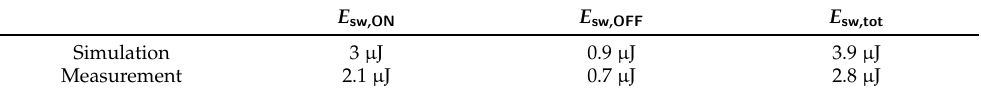
Figure 6. Comparison between simulation and measurement for 200 V/4 A switching transients: ( a ) Turn-ON. ( b ) Turn-OFF. Based on the above waveforms, device turn-ON and turn-OFF switching energy ( E sw , ON , E sw , OFF ) are obtained and compared in Table 4. The difference between simulation and measurement is around 1 µ J, which confirms the accuracy of the model to estimate device switching losses. Table 4. Comparison between simulation and measurement for switching energy.